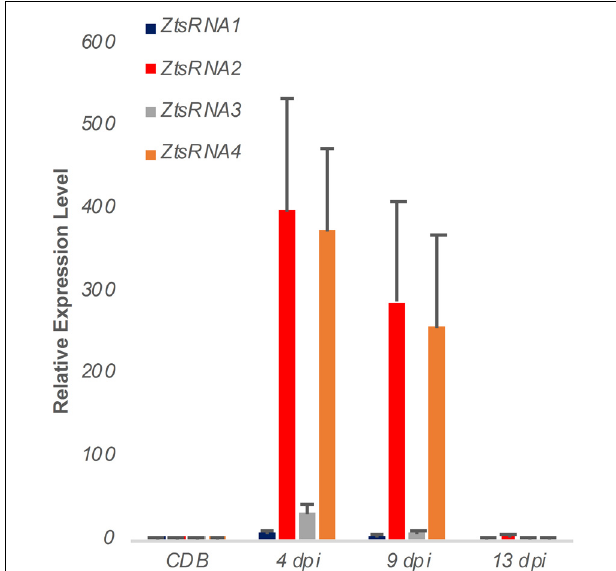
FIGURE 2 | Expression profiling of Zymoseptoria tritici mature sRNAs by stem-loop qRT-PCR. Relative expression of four Z. tritici sRNAs (ZtsRNA1 – ZtsRNA4) from the fungus grown in vitro (CDB) or in planta (leaf tissue at 4, 9, and 13 days post-inoculation, dpi). There were 3 biological replicates in this experiment. Bars indicate